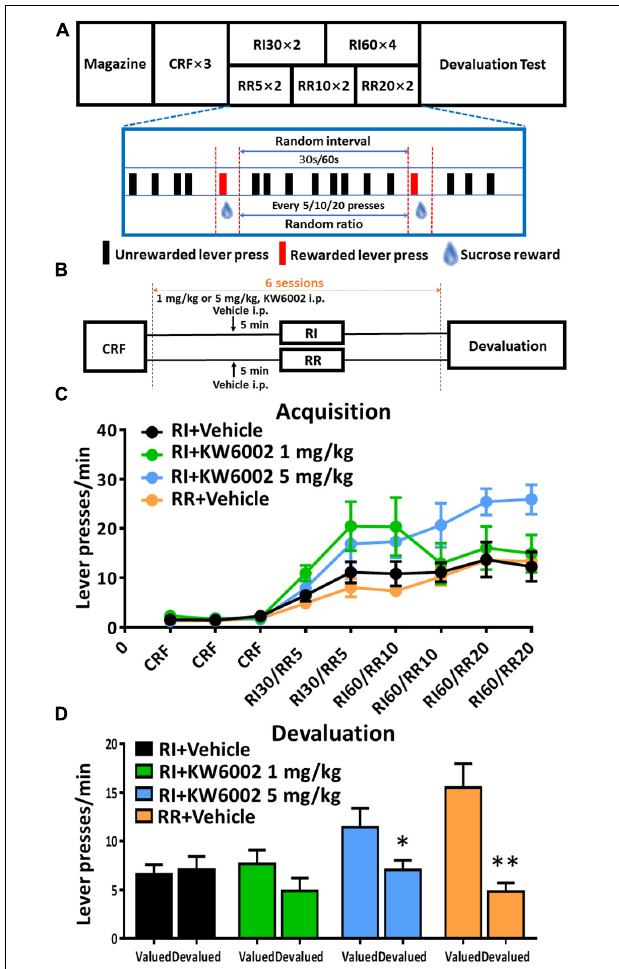
FIGURE 1 | Pharmacological blockade of A 2A Rs promoted goal-directed valuation. (A) Satiety-based instrumental behavior design schematic. Mice underwent Magazine-CRF-RI/RR-Devaluation procedure sequentially. CRF, continuous reinforcement; RI, random interval; RR, random ratio. (B) KW6002 and vehicle were injected intraperitoneally 5 min before daily RI training session at different doses (1 and 5 mg/kg), meanwhile vehicle was administrated 5 min before daily RR training session as another control group to form goal-directed behavior (C) . All mice gradually increased their lever presses in the RI/RR training sessions (training main effect: p < 0.001). There was the interaction effect of training sessions X drug administration groups ( p = 0.006) and between subject effect of different drug administration groups ( p = 0.022). The statistical significance was only observed between RI+KW6002 5 mg/kg and RR + Vehicle groups ( post hoc by Bonferroni test, p = 0.035). (D) In the devaluation test, mice trained with RI and RR procedures performed habitual ( p = 0.755) and goal-directed ( p = 0.002, ∗∗ p < 0.01) behaviors, respectively, as designed. Mice received 1 mg/kg KW6002 tended to decrease their lever presses in the devalued condition but with no statistical significance ( p = 0.141), while mice of 5 mg/kg group displayed markedly goal-directed performance in the devaluation test ( p = 0.030, ∗ p < 0.05). All data was analyzed by two-way ANOVA for repeated measurement, followed by post hoc comparison with Bonferroni test [RI group, n = 8; RI+KW6002 (1 mg/kg) group, n = 7; RI+KW6002 (5 mg/kg) group, n = 8; RR group, n = 9].